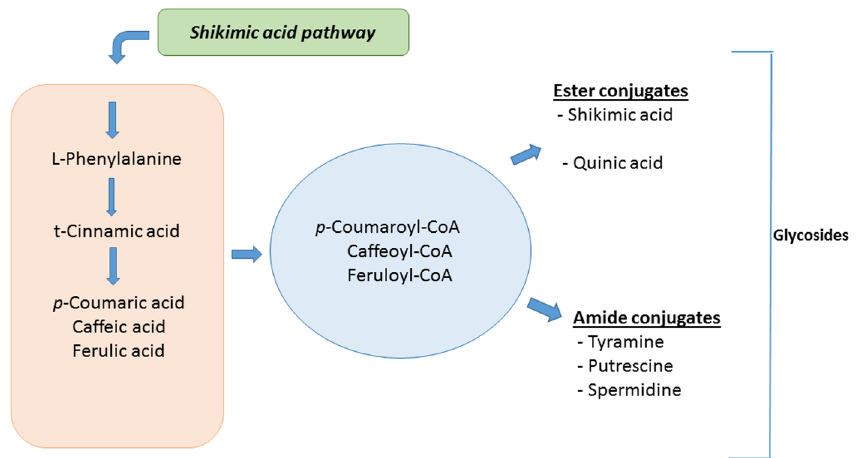
Fig 9. A role for hydroxycinnamic acids and — conjugates as mediators of priming in tobacco cells. Overview of the metabolites and biochemical pathways highlighted by metabolomic analysis of Nicotiana tabacum cells treated with lipopolysaccharides, chitosan and flagellin (flg22). The origin of these priming- associated secondary metabolites lies in the primary metabolites phenylalanine, tyrosine, arginine, proline, glutamic acid and glucose. The accumulation of the ester — and amide conjugates of hydroxycinnamic acids (HCAs) and their rapid hydrolysis upon pathogen attack can allow the plant to launch a more rapid and intense response upon pathogen